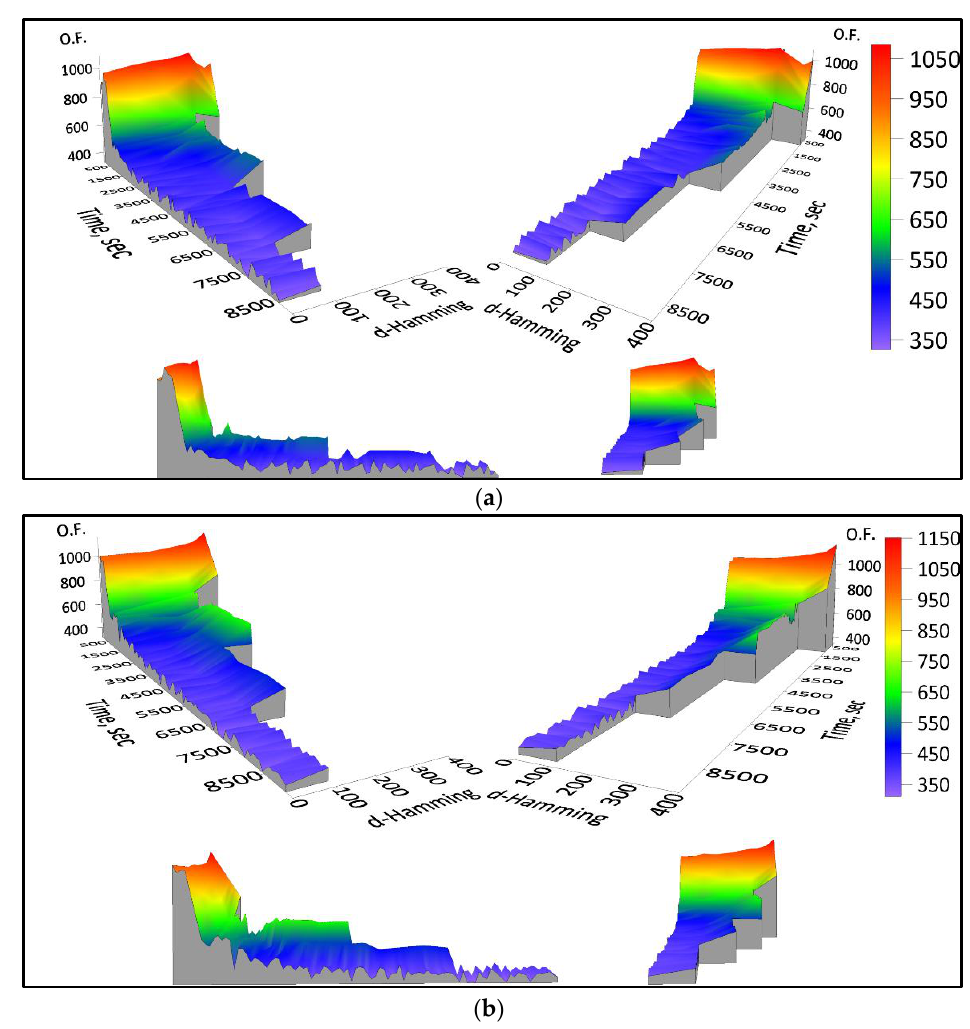
Figure 6. SACP with 48 processes generating the landscape applying cooperation between the processes. Results of 30 tests. ( a ) Instance large01. ( b ) Instance large02.